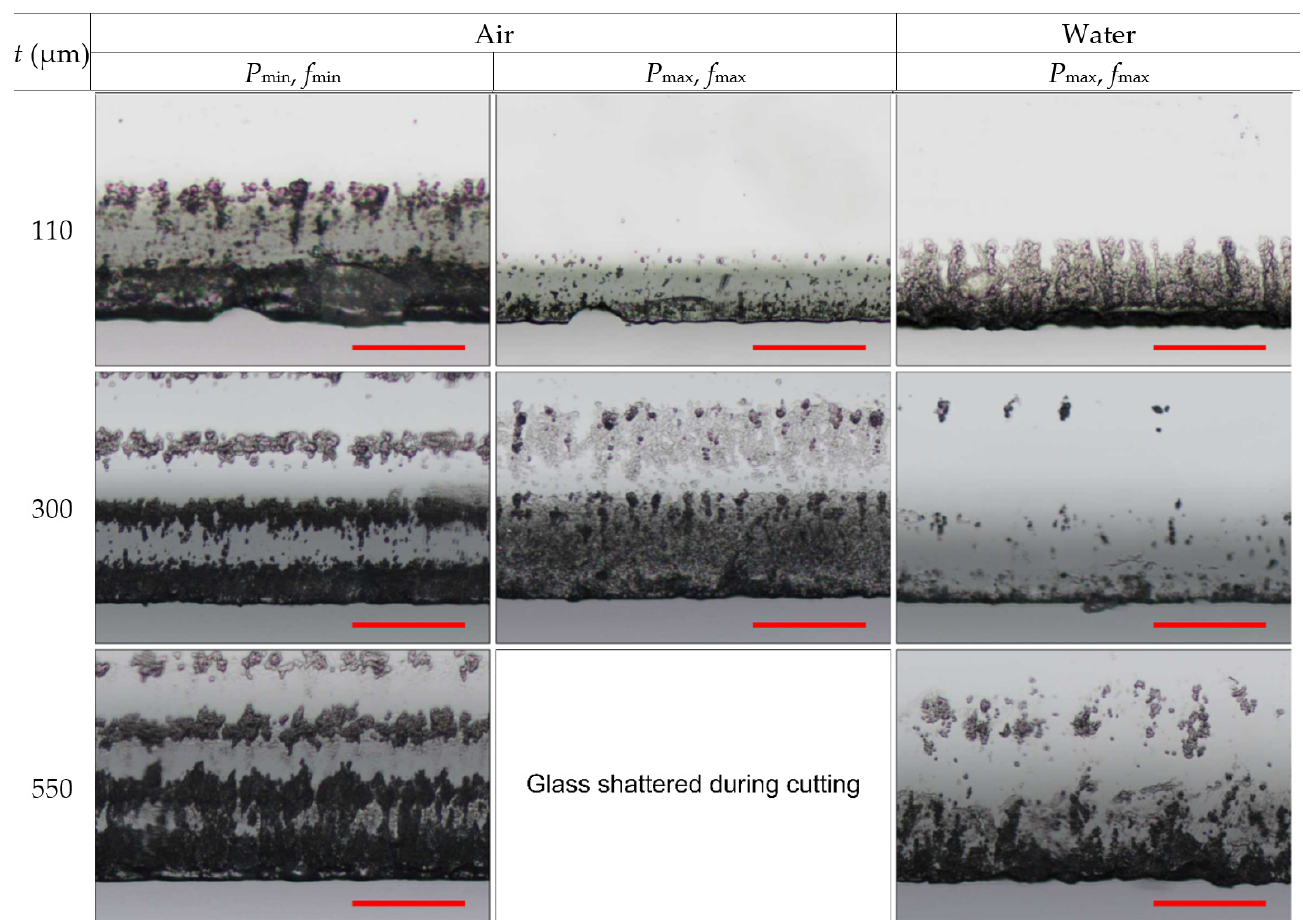
Figure 6. Optical micrographs showing cut edges at the back side of laser-cut glass strips. Rows represent different glass thicknesses, while columns represent different processing conditions. The scale bars represent 100 µm and apply to all panels in the figure.